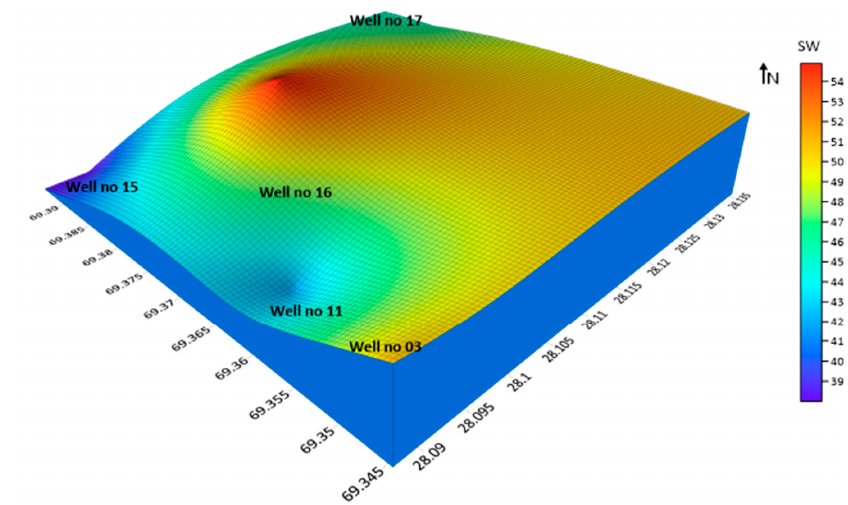
Figure 13. Porosity (POR) variation map computed in (%).